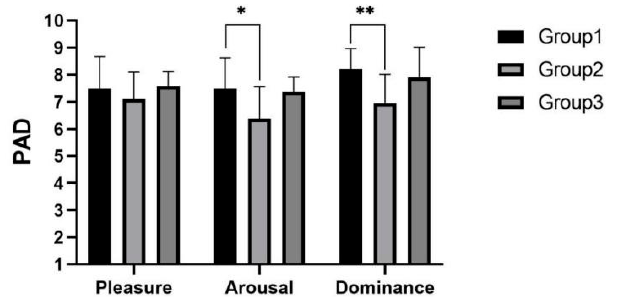
Figure 15. Emotion score in speeding task. * indicates significant difference ( p < 0.05). ** indicates significant difference ( p < 0.01).